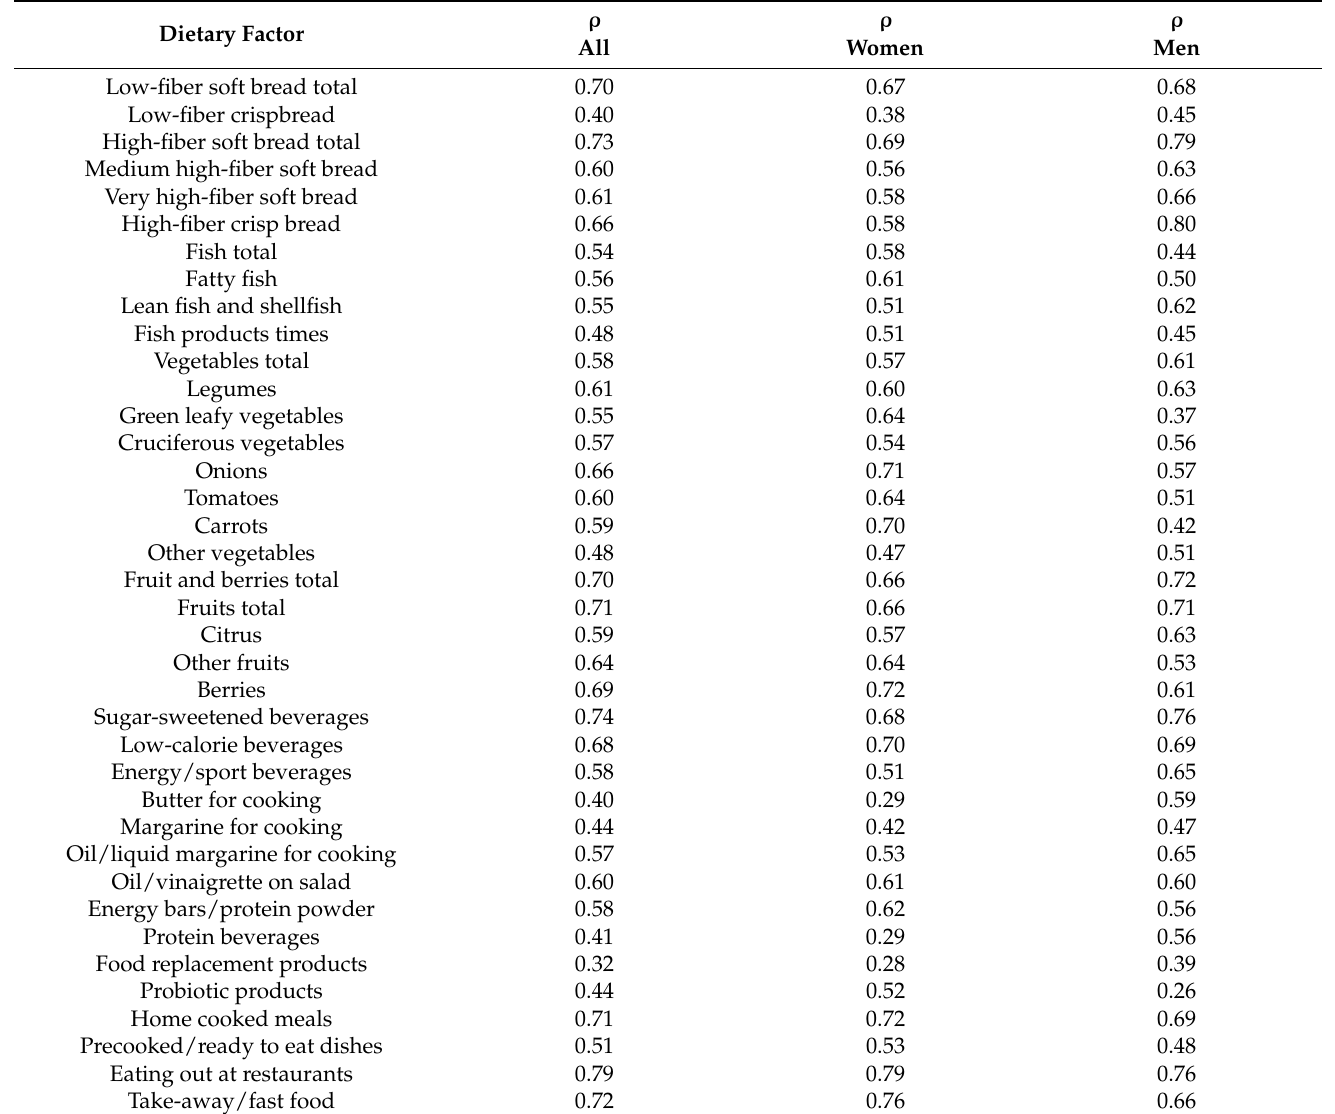
Table 5. Spearman correlations * between repeated assessments of food intakes using the short food frequency questionnaire (SFFQ) (times/month and g/d for fish intake) in 180 women and men from the Malmö Offspring